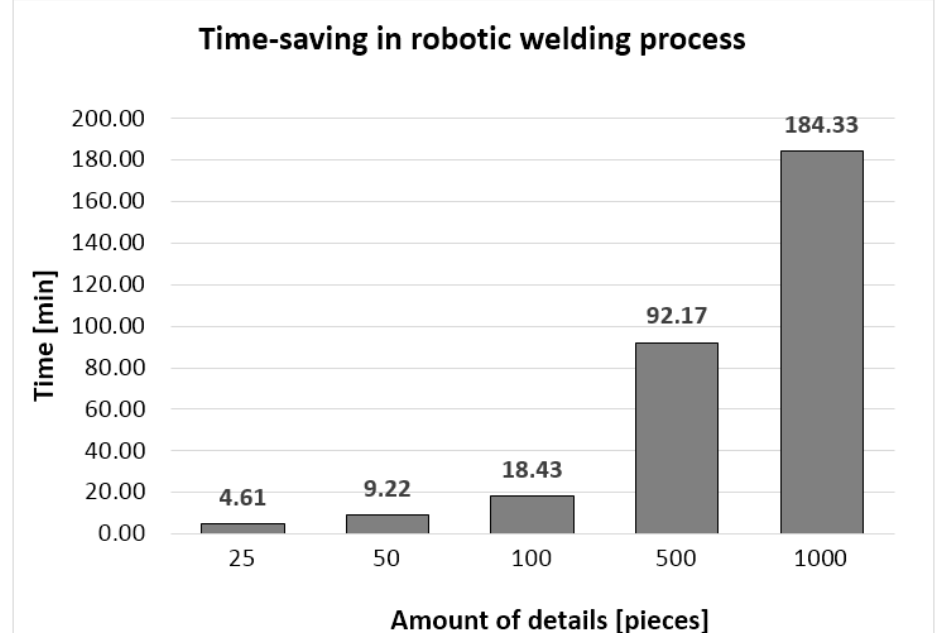
Figure 6. Benefits of the obtained time reduction of the process.